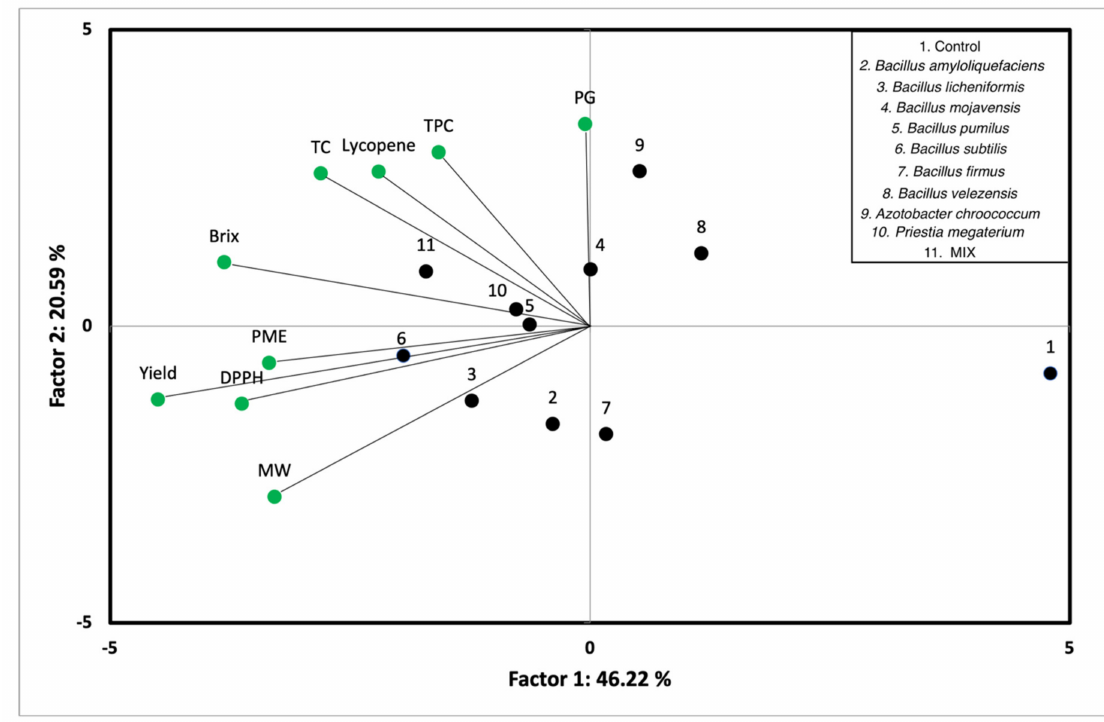
Figure 4. Biplot of principal component analysis of application of different PGPB strains on cultivation of industrial tomato. PG: poligalacturonase activity; TPC: total phenolic compounds; TC: total carotenoids; PME: pectin methylesterase activity; DPPH: sntioxidant activity; MW: mean fruit weight. Mix: mix of P. megaterium + Azotobacter chroococcum